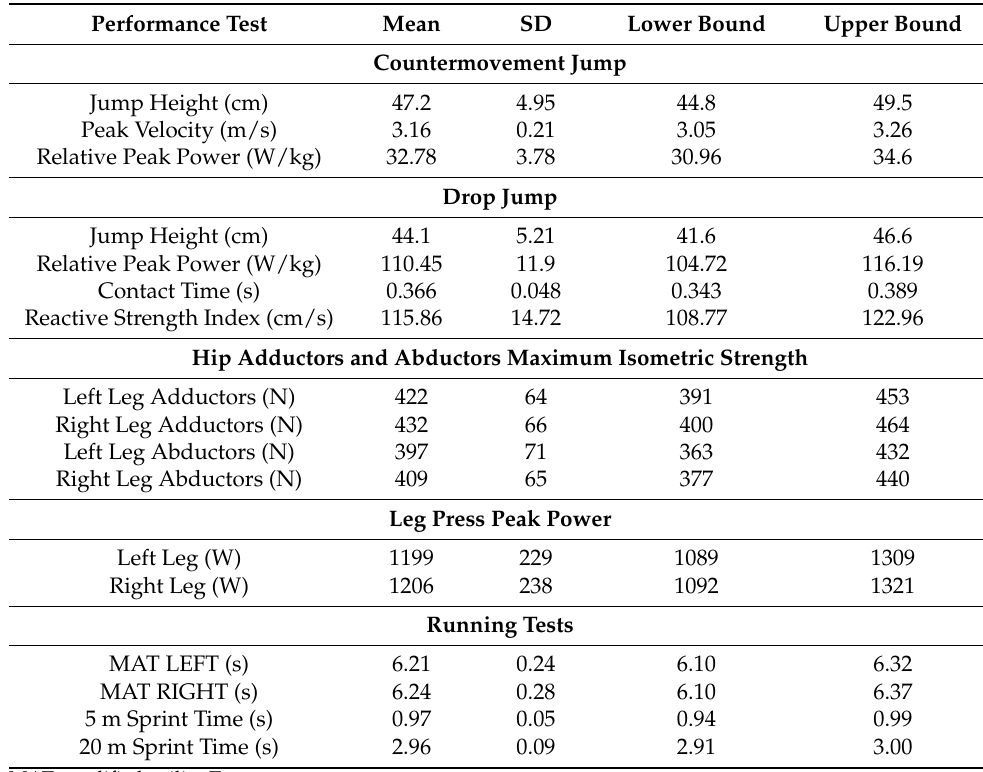
Table 1. Descriptive data (mean ± SD [95% confidence intervals]).